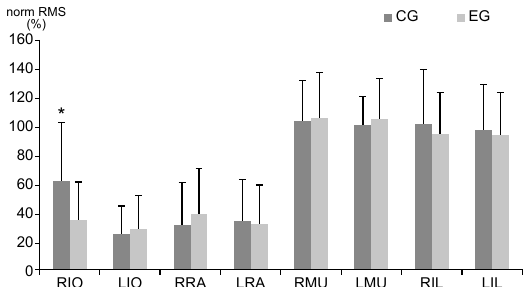
Figure 3. Comparison of the normalized RMS (%) obtained during the Biering-Sorensen test (mean ± standard deviation). CG, control group; EG, experimental group; IO, internal oblique; RA, rectus ab - dominis; MU, lumbar multifidus; IL, iliocostalis lumbar; R, right; L, left; *p < 0.05 when comparing the groups.